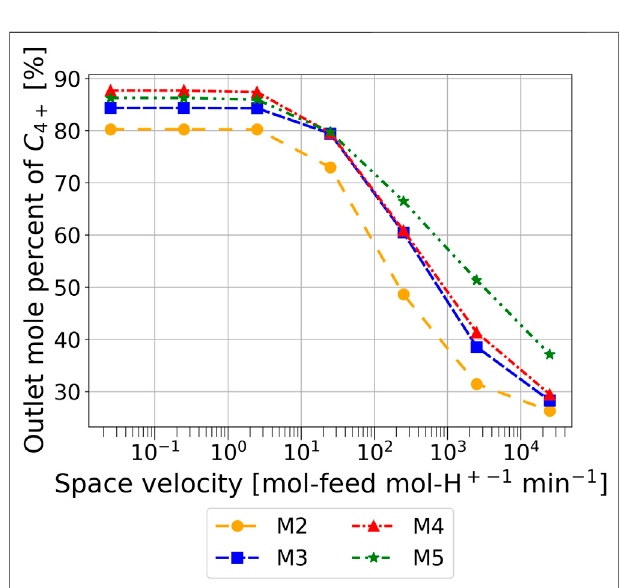
FIGURE11| Outletmolepercentofbuteneandheavierole fi nspredicted atoptimaltemperatureoperationofa4-stagePBRatdifferentspacevelocities predicted by models M2 to M5